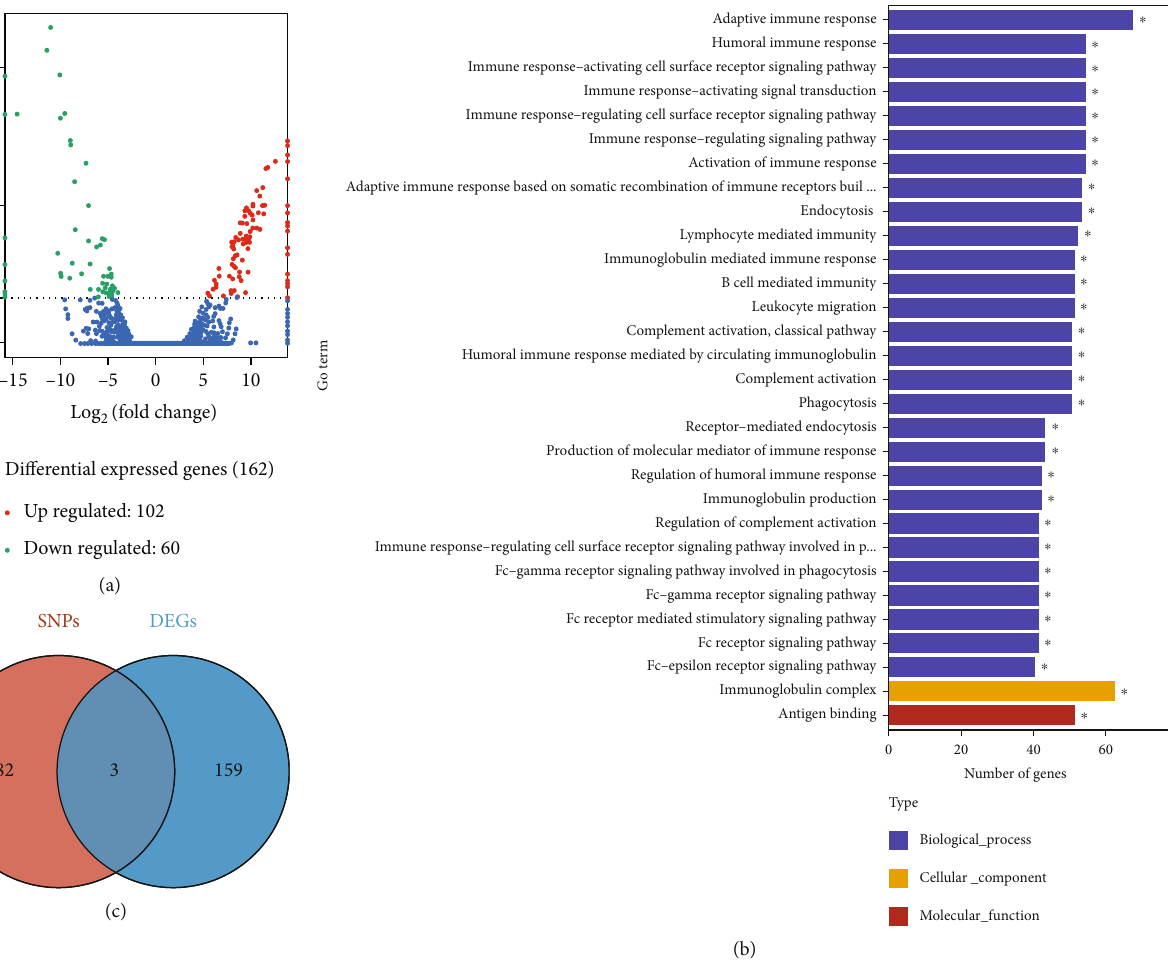
Figure 1: Identi fi cation and functional annotation of DEGs and target SNPs between the control and CAD groups. (a) Volcano plots of 162 DEGs were shown between the two groups with 102 upregulated genes and 60 downregulated genes. (b) GO enrichment analysis depicted DEGs were associated with the immune system and in fl ammatory response. (c) Venn diagram exhibited three intersected genes including IL-33 between DEGs and SNP mutation-related genes. Abbreviations: DEGs: di ff erentially expressed genes; SNP: single nucleotide polymorphism; CAD: chronic renal graft dysfunction; GO: gene